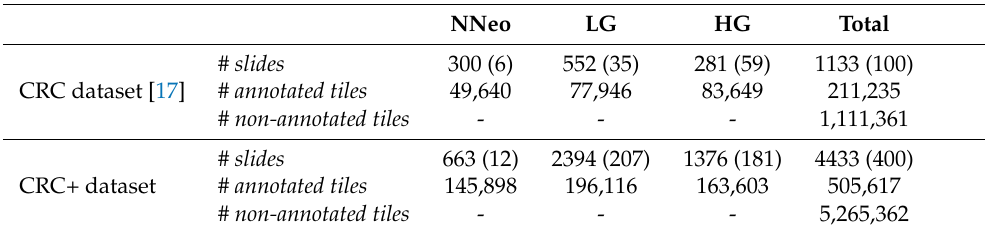
Table 1. CRC dataset summary, with the number of slides (annotated samples are detailed in parenthesis) and tiles distributed by